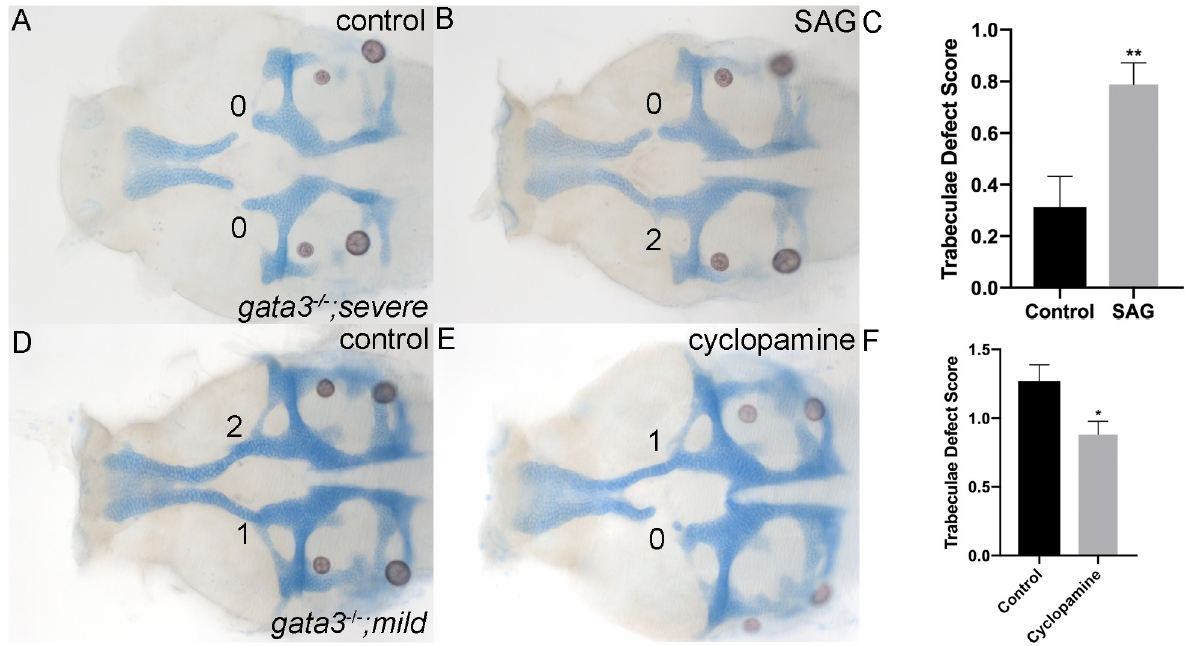
Fig 8. Shh signaling can modulate the trabeculae phenotype in gata3 mutants. (A-B) Flat mounts of 5dpf gata3 b1075 /b1075 “severe” background neurocrania anterior to the left. (A) Phenotype of “severe” gata3 -/- with characteristic severely affected trabeculae. (B) Representative image of a gata3 -/- “severe” embryo treated with the Hh agonist SAG, showing the partial rescue of the trabeculae. (C) Graph depicting trabeculae defect scores for untreated and SAG-treated gata3 -/- . The trabeculae phenotype was significantly improved in the SAG-treated embryos compared to controls via t-test (p = 0.0022). Control embryos x = 0.3125, SEM = 0.1197, n = 16; SAG treated embryos x = 0.7879, SEM = 0.08436, n = 33). (D-F) Flat mounts of 5dpf gata3 b1075 /b1075 “mild” background neurocrania anterior to the left. (D) Phenotype of “mild” gata3 -/- showing mildly affected trabeculae. (E) Typical image of a gata3 -/- “mild” embryo treated with the Shh antagonist cyclopamine displaying a much more severe phenotype. (F) Graph depicting trabeculae defect scores for untreated and cyclopamine-treated gata3 -/- . Trabeculae phenotype was significantly exacerbated in the cyclopamine-treated embryos compared to controls as determined by t-test p = 0.0174, Control x = 1.269, SEM = 0.1184 n = 26; cyclopamine-treated embryos x = 0.88, SEM = 0.0975, n = 50).